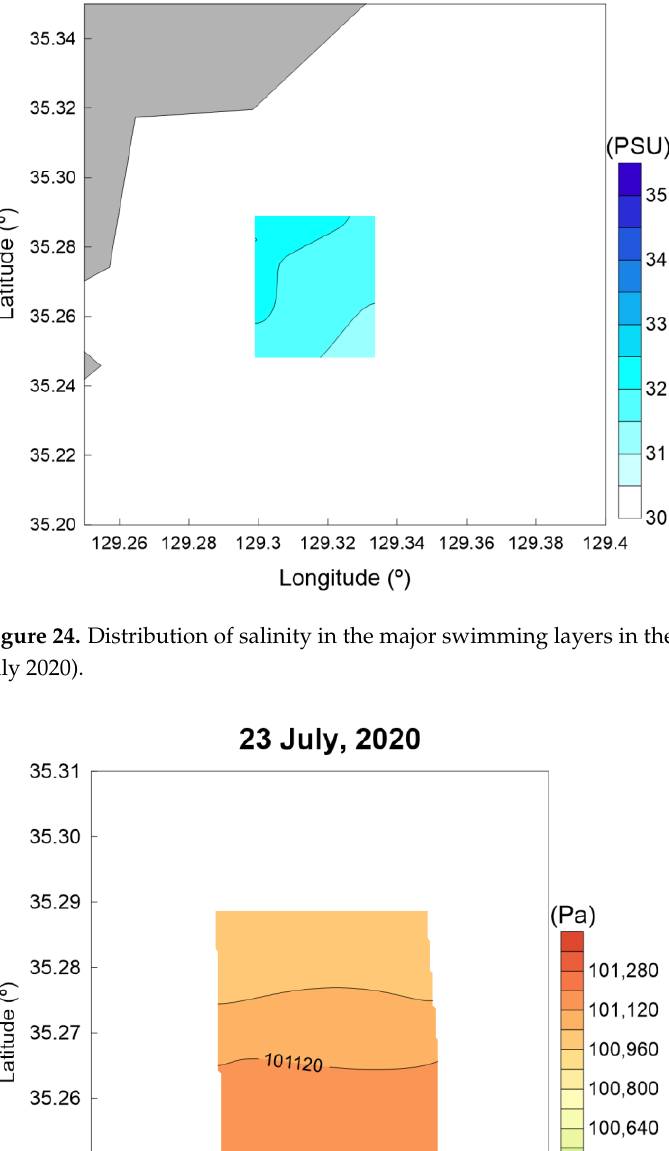
Figure 23. Distribution of temperature in the major swimming layers in the Gijang coastal waters sea (23 July, 2020).